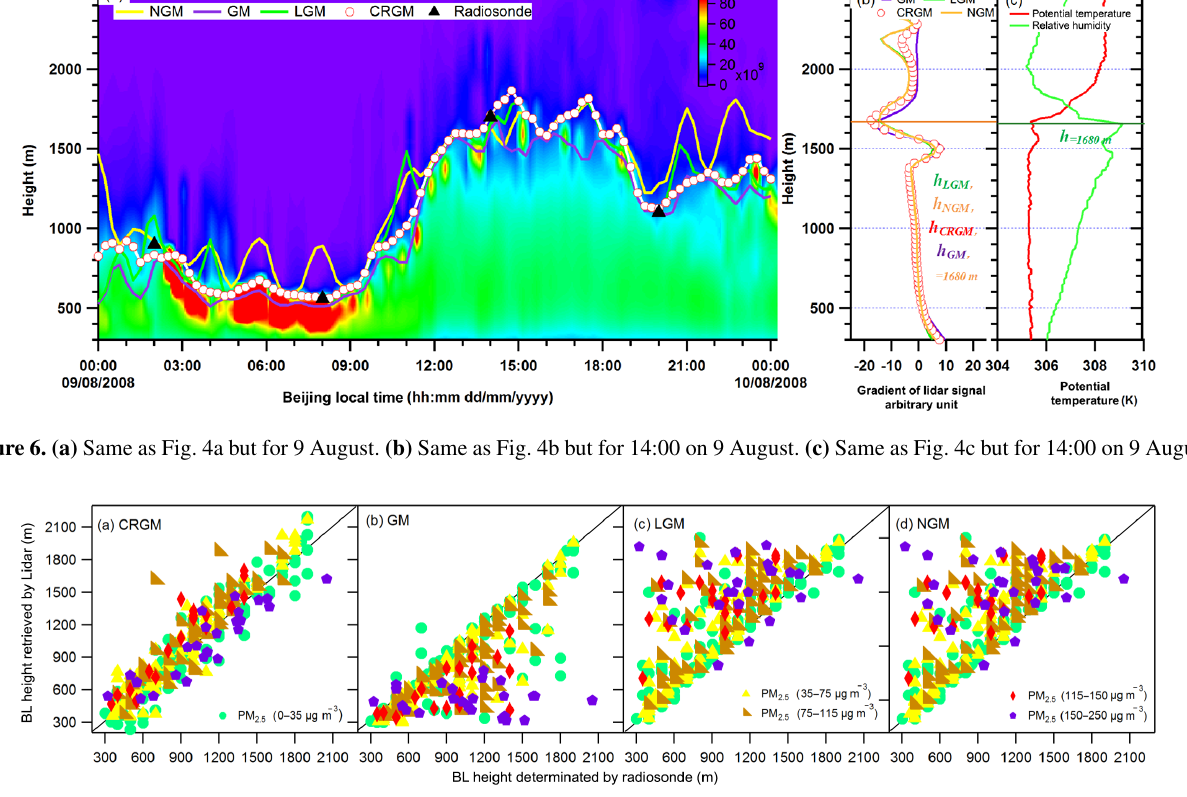
Figure 7. Comparison of H CRGM , H GM , H LGM , and H NGM with the BLH retrieved from radiosonde measurements. The x axis shows the radiosonde retrieval, and the y axis is the lidar retrieval using the different algorithms. The solid line indicates y = x . (a) CRGM, (b) GM, (c) LGM, (d) NGM. Different marks represent the comparisons under different pollution conditions (PM 2 . 5 concentrations). The comparisons under PM 2 . 5 concentrations less than 35, 35–75, 75–115, 115–150, and 150–250µgm − 3 are shown as green circles, yellow triangles, brown triangles, red diamonds, and purple hexagons, respectively.